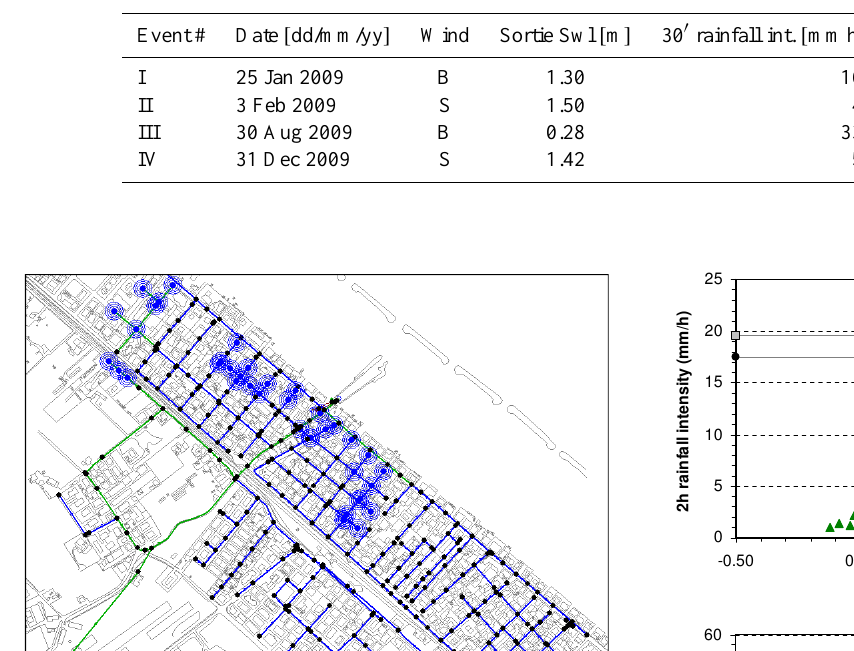
Table 2. Conditions during the 4 events in the year 2009 causing urban flooding. B and S in the column Wind indicates the storm typology, respectively Bora and Scirocco.